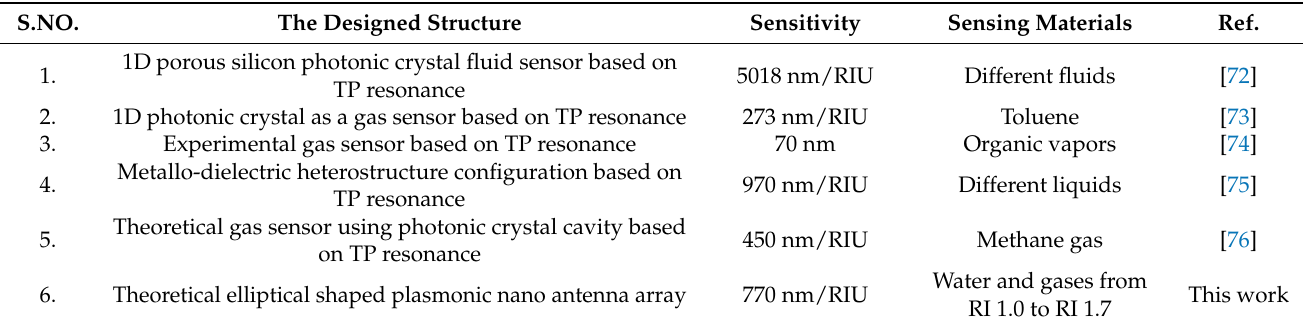
Table 1. Comparision between proposed work with the Tamm sensors.